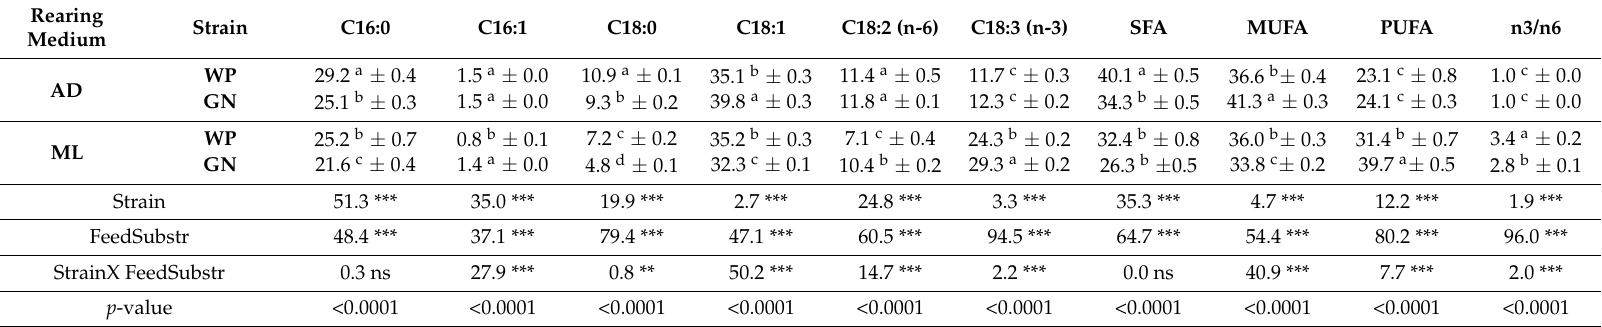
Table 3. Fatty acid composition (% of total fatty acids) of silkworm pupae of White Polyhybrid (WP) and Golden Nistari (GN) strains fed an artificial diet (AD)